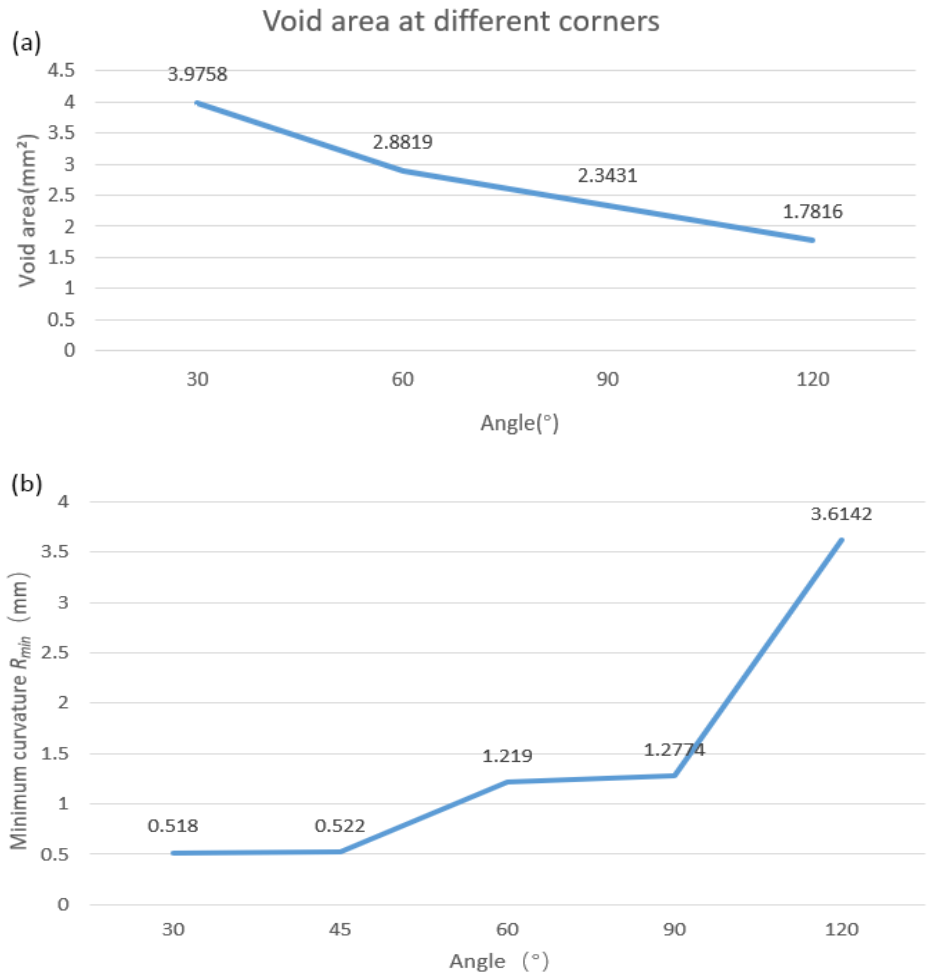
Figure 7. Fiber pose diagram in the nozzle, ( a ) initial position of fiber, ( b ) fiber upright state, ( c ) position during fiber movement, ( d ) print track graph.